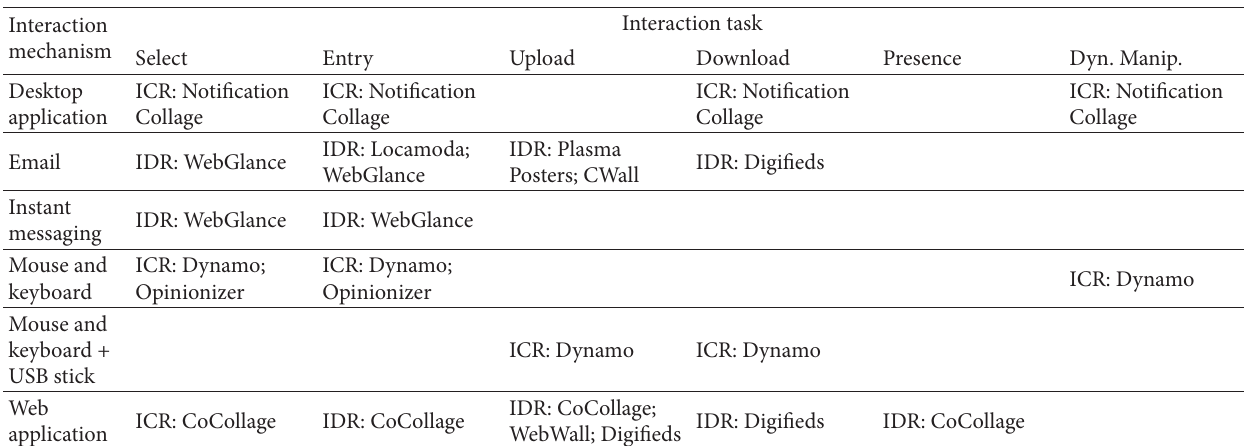
Table 5: Mapping between interaction tasks and desktop-like